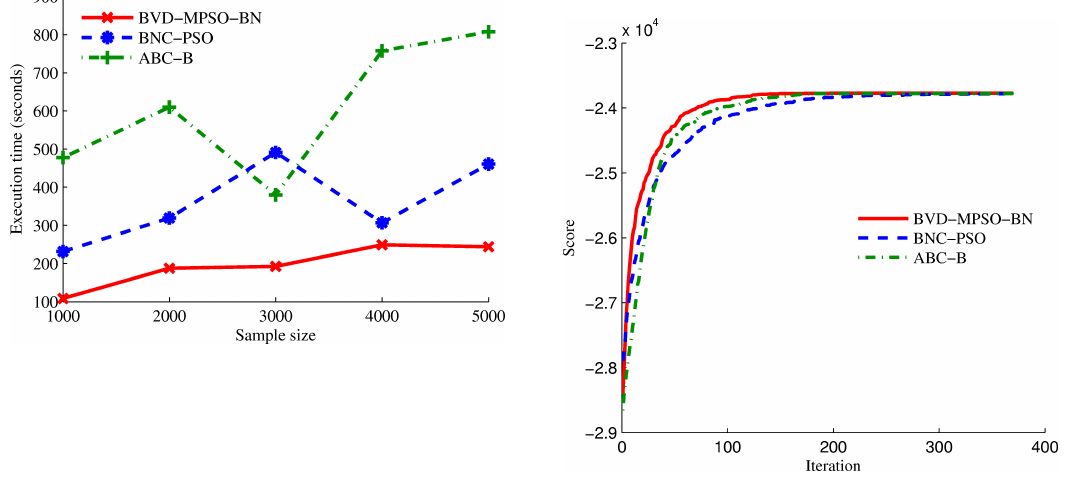
Fig. 3. Time performance of three algorithms on Alarm network. Fig. 4. The score convergence of three algorithms on Alarm-